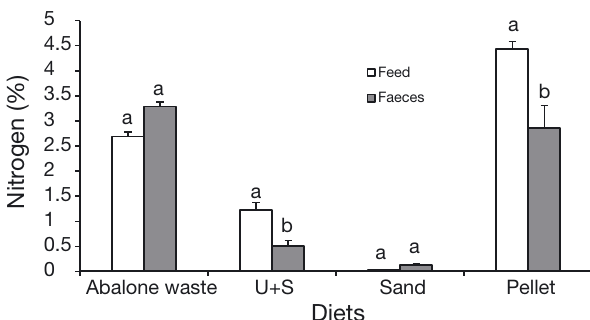
Fig. 5. Nitrogen content (%) of feed and faeces of Neosticho- pus grammatus fed 4 experimental diets. Data are mean ± SE (n = 4). Different letters above each bar within a column indicate a significant difference between feed and faeces (t - test, p < 0.05). U+S: Ulva lacinulata mixed with sand